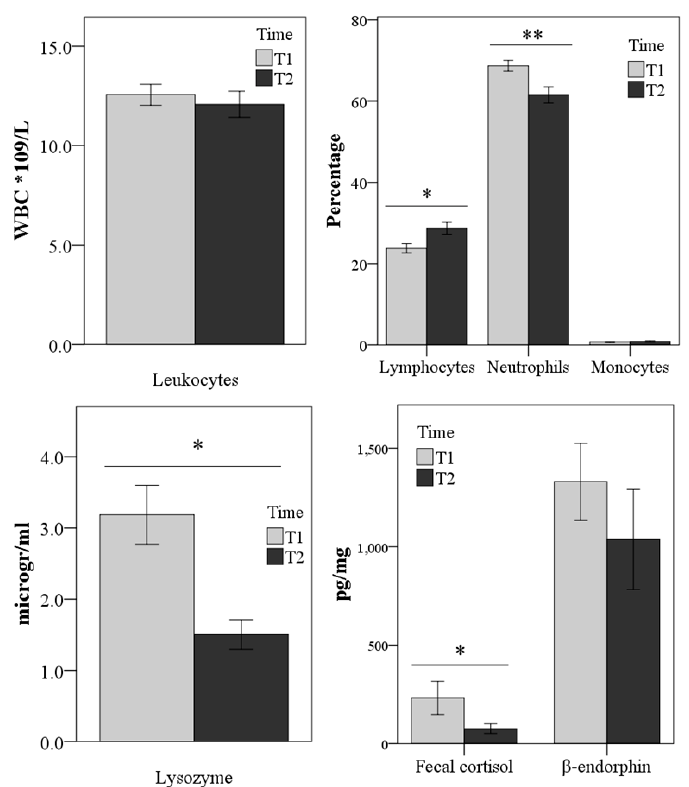
Figure 1. Differences in laboratory parameter values between the first (three days of shelter intake, Time 1 = T1) and the second sampling (after four weeks of acclimation in the shelter, Time 2 = T2). ** p < 0.01, * p < 0.05 (univariate analysis). Basophils are not represented because they were constant.